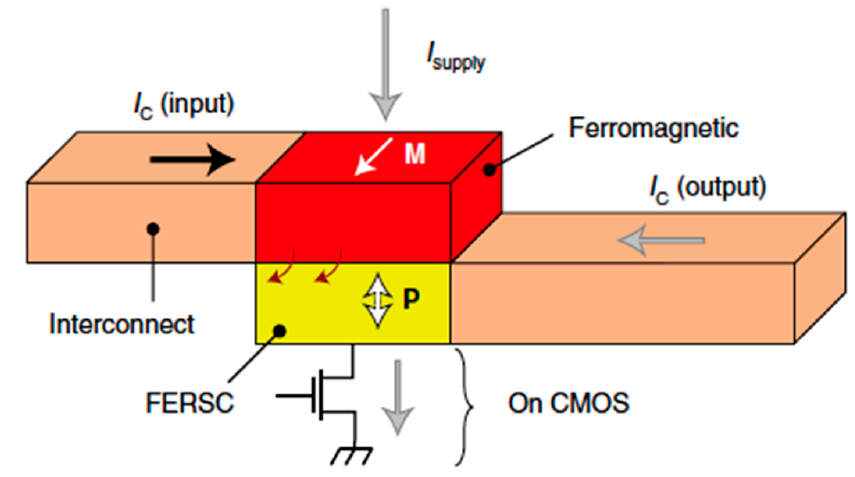
Figure 5. Concept of a spin–orbit transduction device with FERSC exploiting the ferroelectric control of the SCC. A ferromagnetic layer with fixed magnetization injects a spin-polarized current into the active FERSC element when the supply current (I supply ) is on. An output charge current is generated by inverse spin-hall effect with a sign related to the polarization state. Reprinted with permission from Ref. [23]. Copyright © 2022 Springer